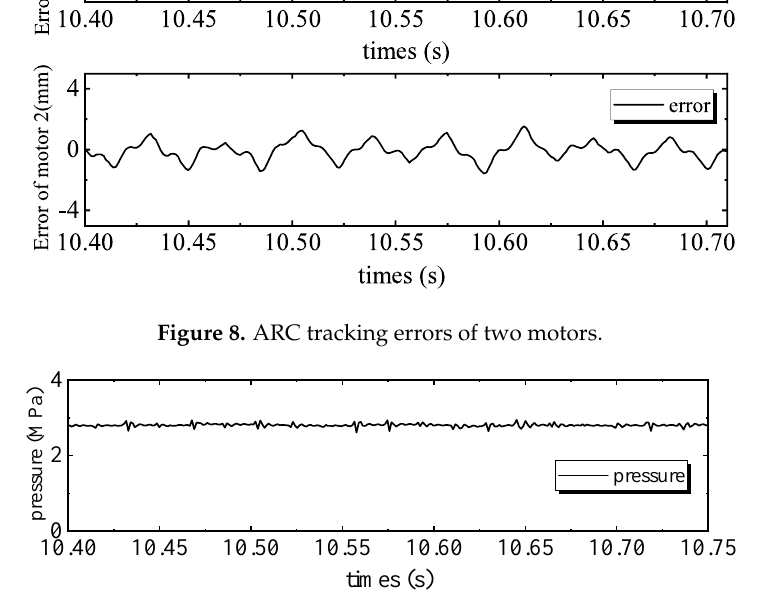
Figure 9. Load pressure of the linear drive collaborative rectification structure pump of